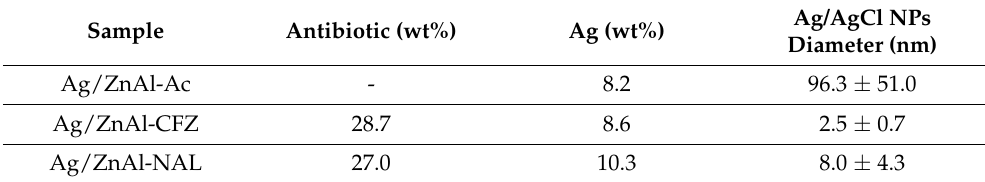
Table 2. Weight percentage of intercalated antibiotics and silver deposited over each sample; the diameter of silver NPs (in form of Ag or AgCl) determined by TEM is also